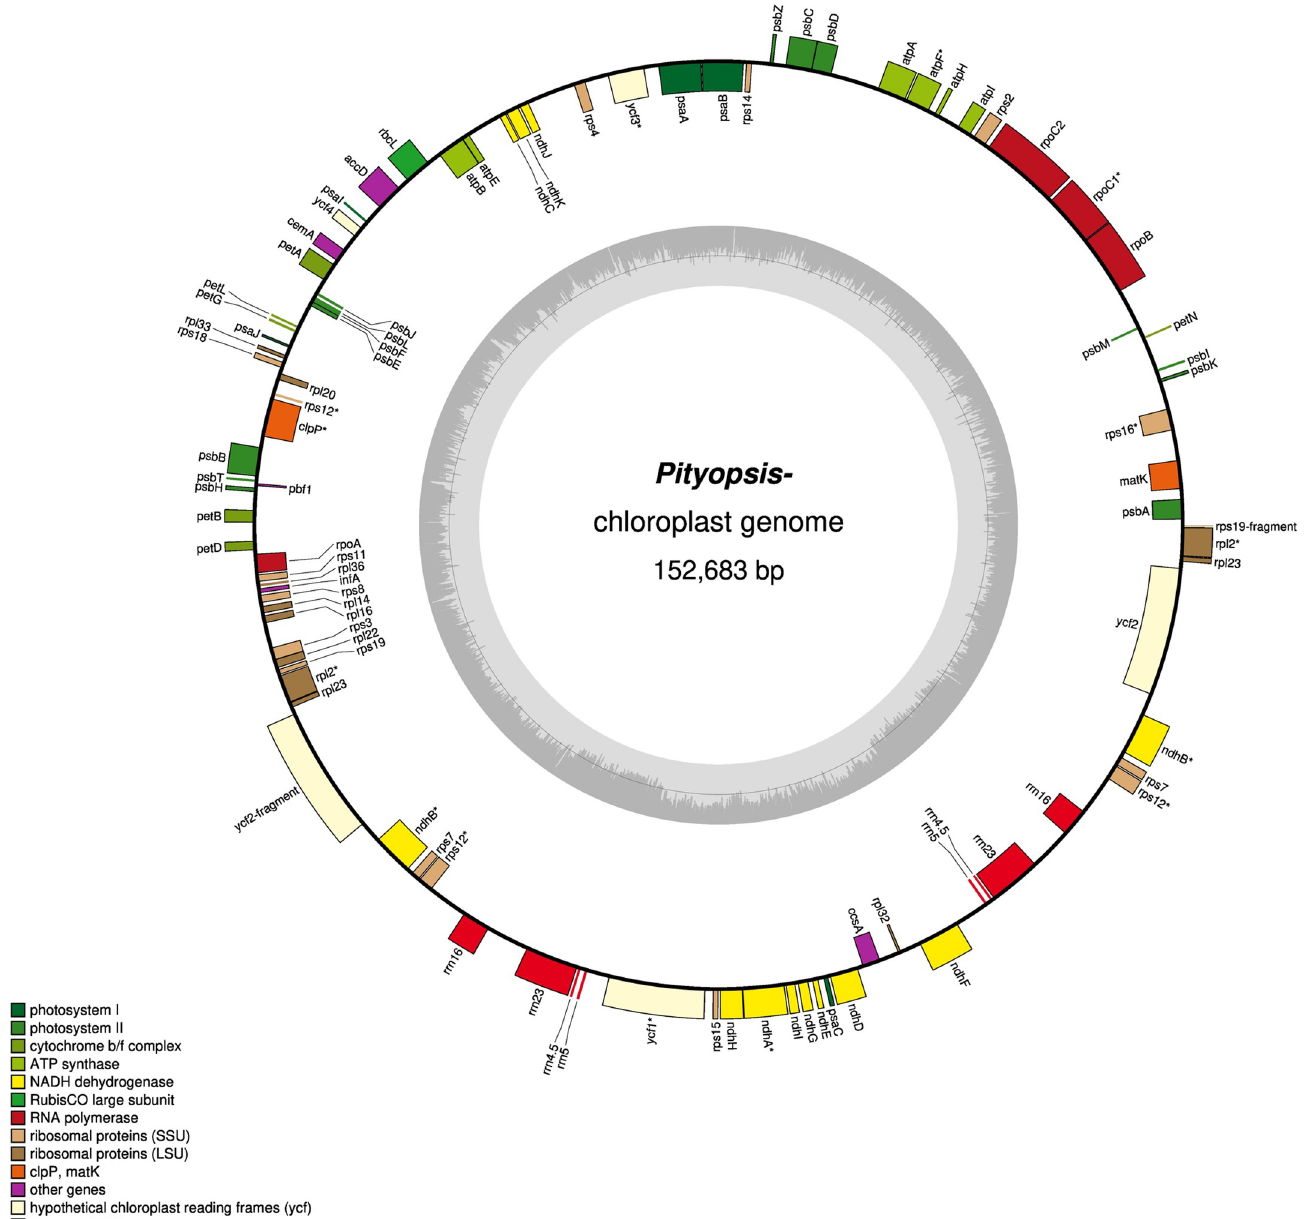
Fig 1. Visualization of Pityopsis falcata chloroplast gene map with annotations. The inner circle is GC content. Genes are color coded based on function as per the legend. Genes on the inside of the outer circle are minus (-) strand and genes on the outside of the outer circle are plus (+) strand.